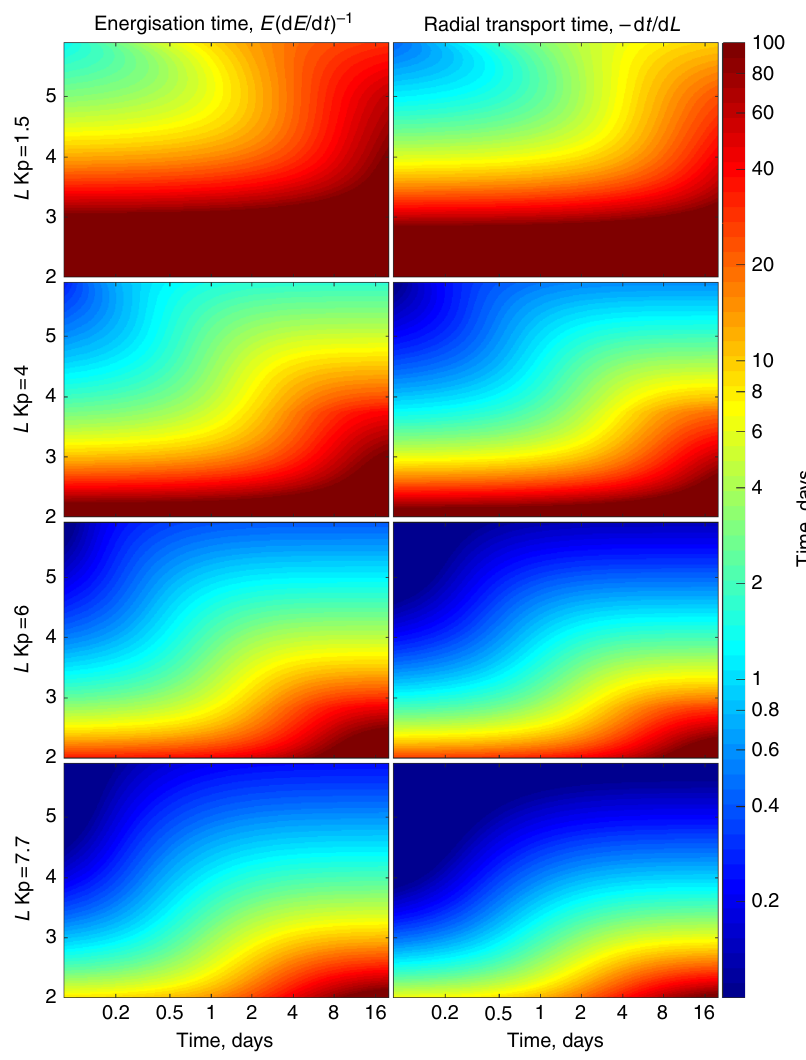
Fig. 5 ULF wave radial diffusion energisation time and radial diffusion transport time as a function of L -shell and time. Color contours of the e-fold energization time speci fi ed by E (d E /d t ) – 1 (left column, derived from Eq. (2)) and the radial transport time speci fi ed by – (d L /d t ) – 1 (right column, derived from Eq. (1)) showing both of these times increase steeply with decreasing L -shell (see Methods section for more details). Similar to Fig. 4 in the main article, the initial electron PSD is set to zero, the PSD at the outer boundary is a constant derived from measured 2.1 MeV fl ux and the diffusion coef fi cients, D fi ed by Kp = 1.5, 4.0, 6.0, and 7.7. Note that during the 20-month time interval examined by Baker et al. 18 , at most, the geomagnetic LL [Ozeke] are speci activity remained at Kp > 1.5, Kp > 4.0, Kp > 6.0, and Kp = 7.7 for 126, 30, 9, and ≤ 3 h, respectively. As shown in this fi gure, these time intervals are